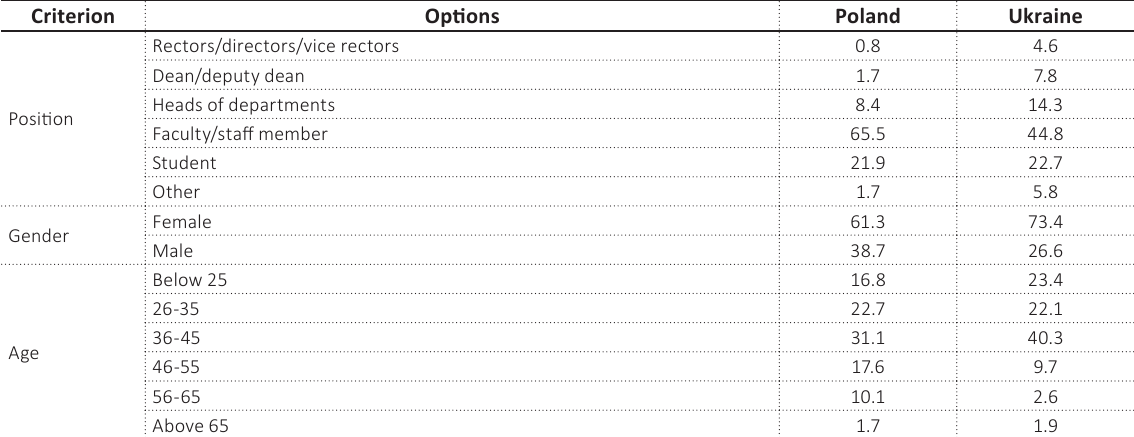
Table 2. Demographic characteristics of the respondents,